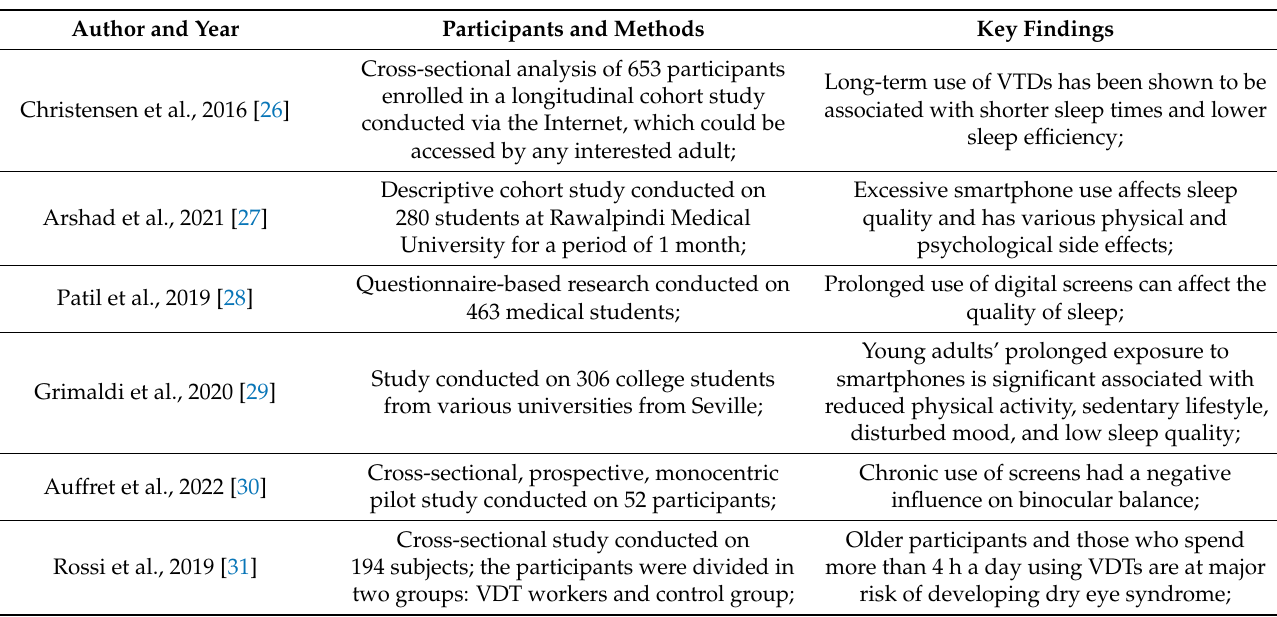
Table 1. Published studies that analyze the effect of prolonged digital screen use on quality of life and